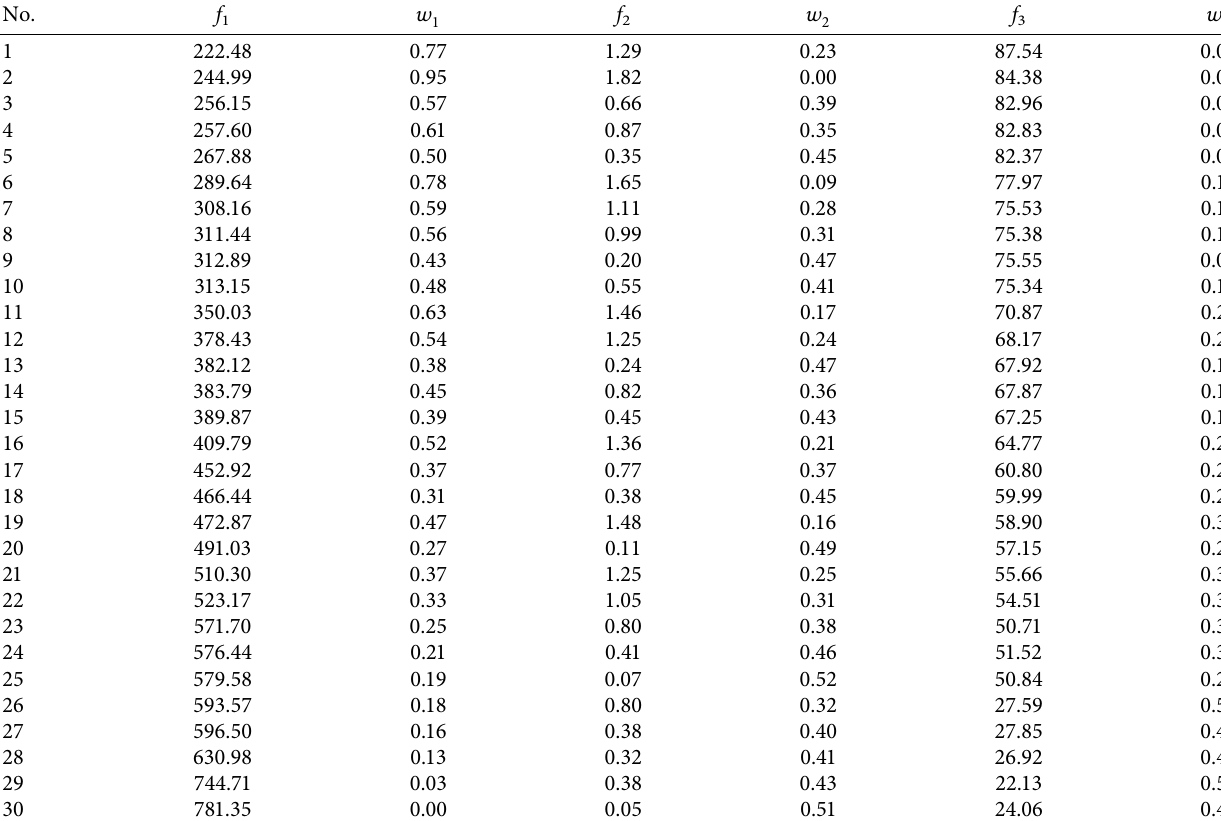
Table 1: Representative Pareto optimal solutions and weights at a casting speed of